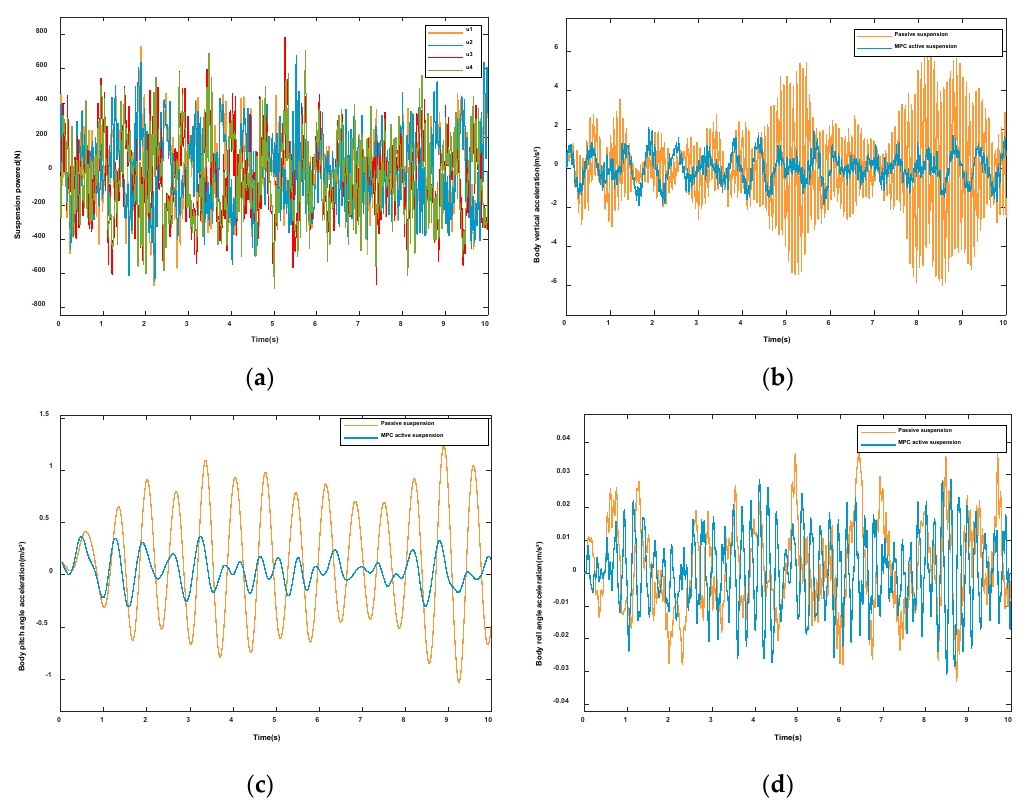
Figure 6. Vehicles under normal driving conditions: ( a ) Suspension actuation force. ( b ) Vertical acceleration . ( c ) Pitch angular acceleration . ( d ) Roll angular acceleration.